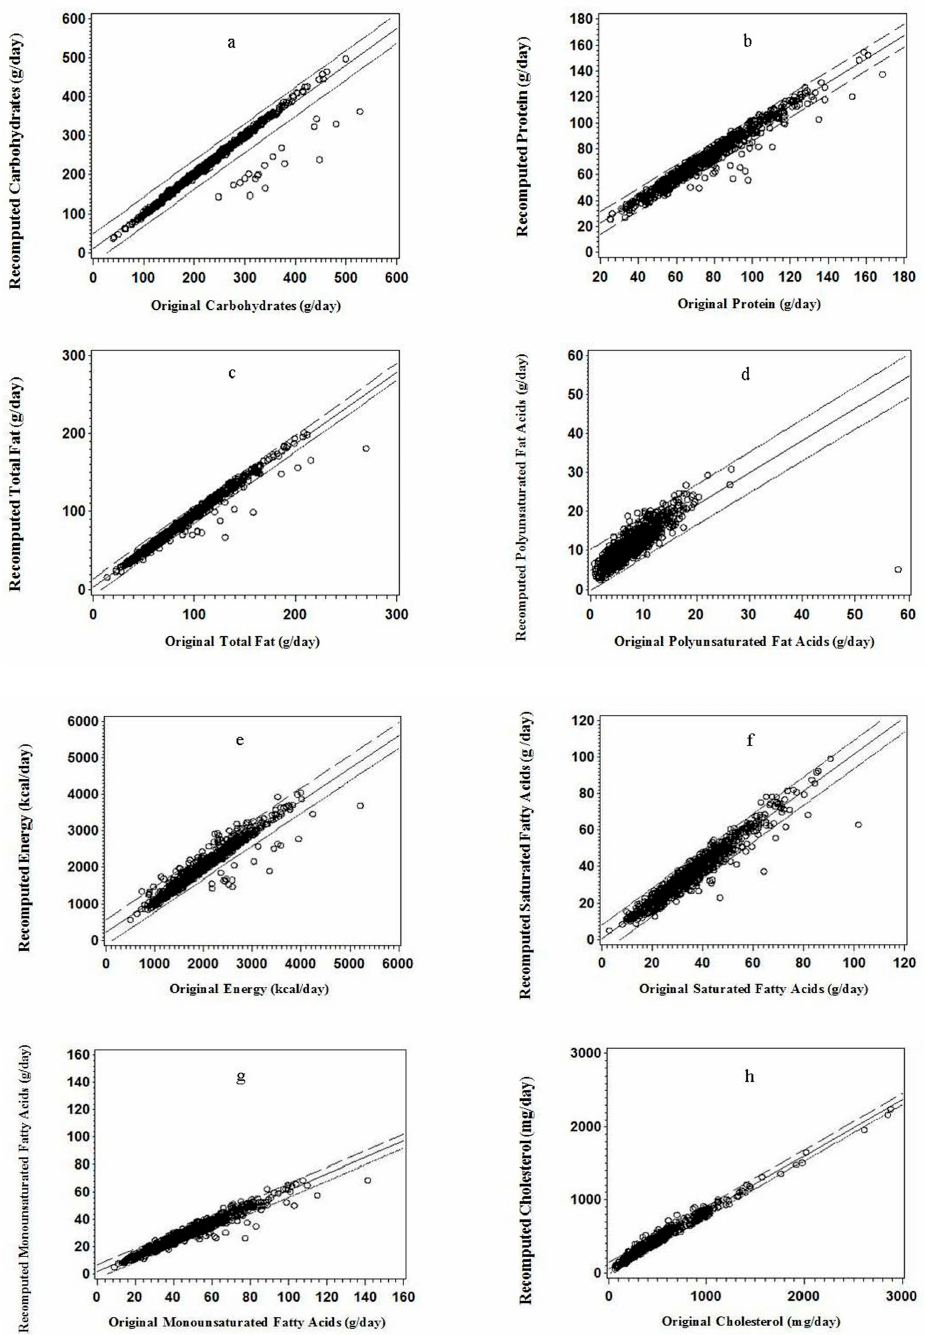
Figure 1. Regression plots for the recalculated value versus the original value: ( a ) carbohydrate; ( b ) protein; ( c ) total fat; ( d ) polyunsaturated fatty acids; ( e ) energy; ( f ) saturated fatty acids; ( g ) monounsaturated fatty acids; and ( h ) cholesterol ( n = 910).